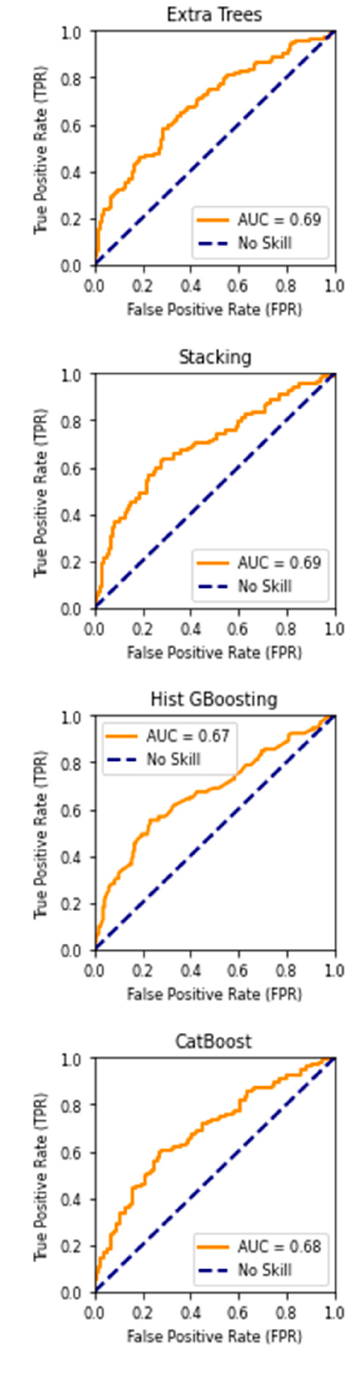
Figure A1. ROC curve.